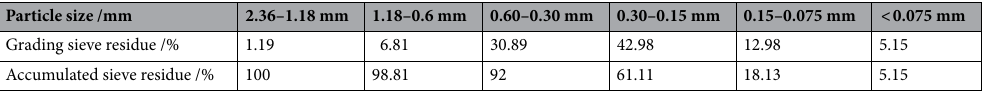
Table 1. Grain gradation of tailings.